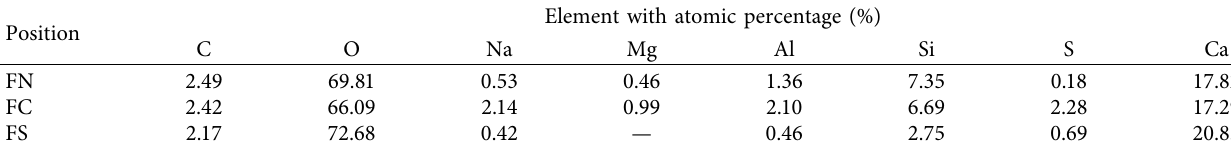
Table 3: Chemical compositions of